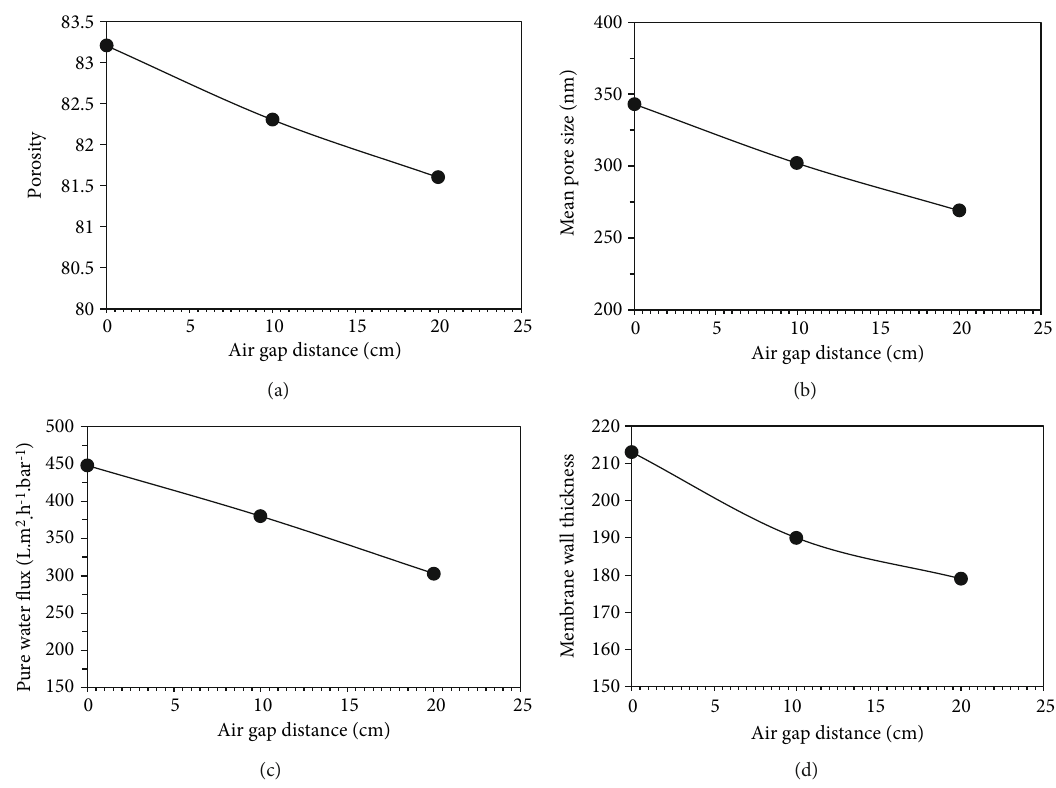
Figure 13: E ff ect of take-up speed on pure water fl ux on the membrane porosity (a), mean pore size (b), mean pure size (c), pure water fl ux (d), and membrane wall